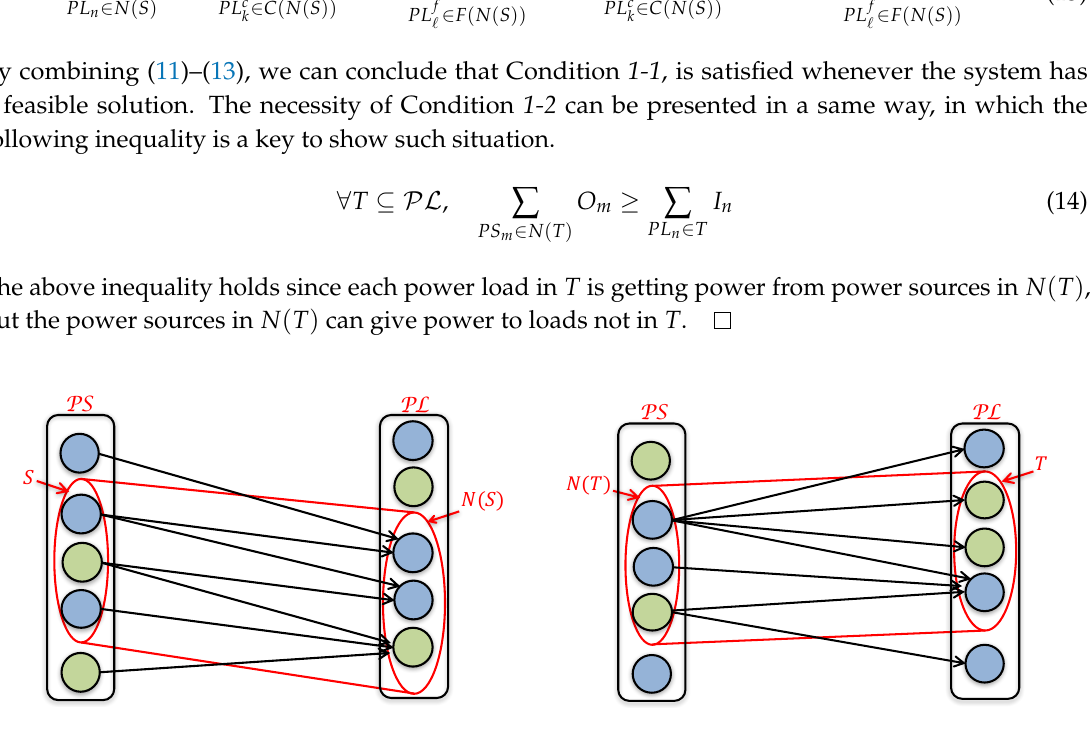
Figure 5. Illustration of subsets of power sources and loads. ( a ) Subset S of power sources and neighbor/connected set N ( S ) ; ( b ) Subset T of power loads and its neighbor/connected set N ( T )